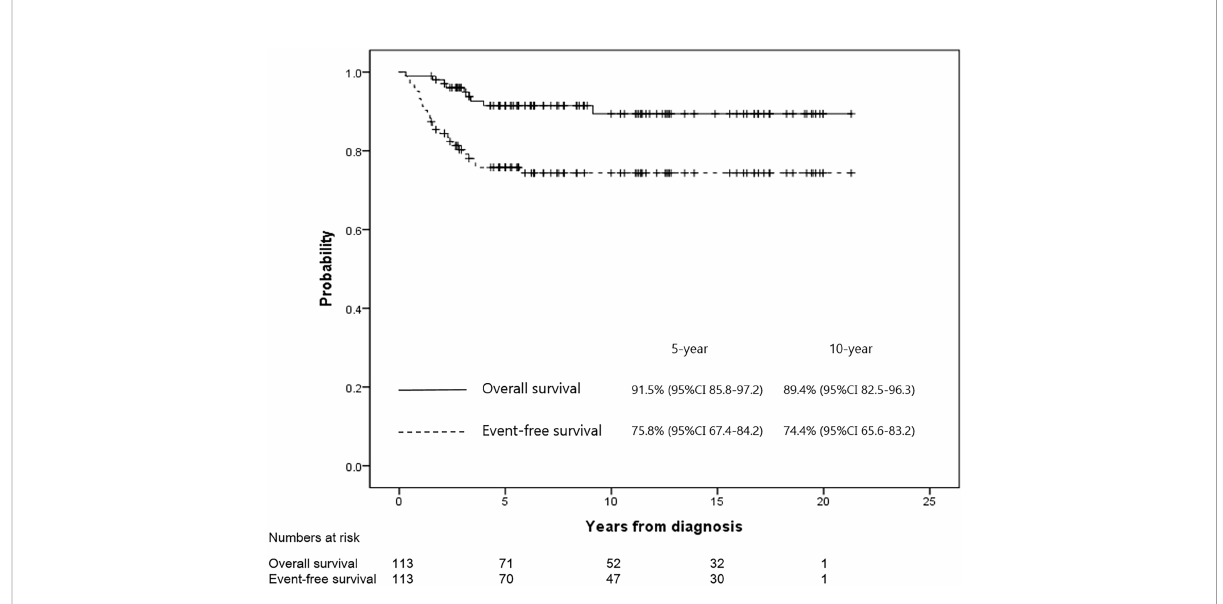
FIGURE 2 The EFS and OS rates for all patients were 75.8% and 91.5% at 5 years, and 74.4% and 89.4% at 10 years, respectively.